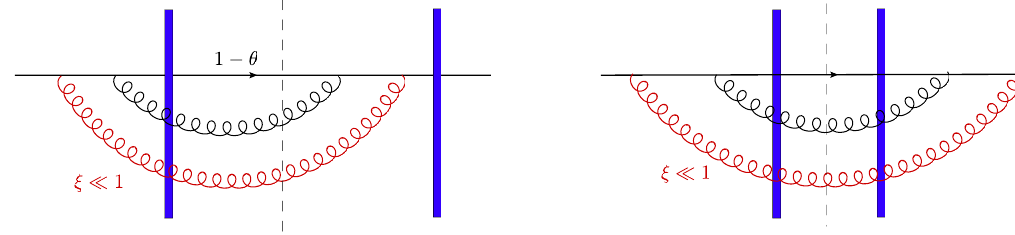
Figure 12 . The four diagrams which dominate the cross-section (3.39) in the eikonal limit ξ → 0 in which the first emitted gluon (shown in red) is soft.